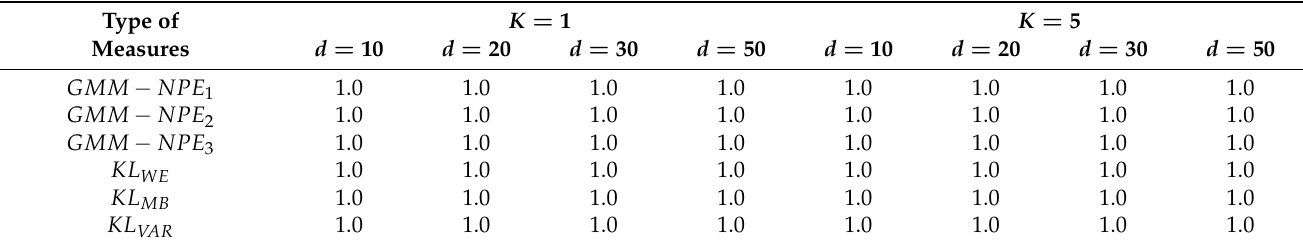
Table 4. Results in the form of recognition accuracy, obtained on the synthetic data: l = 1, t ∈ [ 0,5 ] , N = 800, M = 200, m 1 = 0, m 2 = 10 h , with h = [ h 1 , . . . , h d ] T , h i ∼ U ([ 0,1 ]) , i = 1, . . . , d .